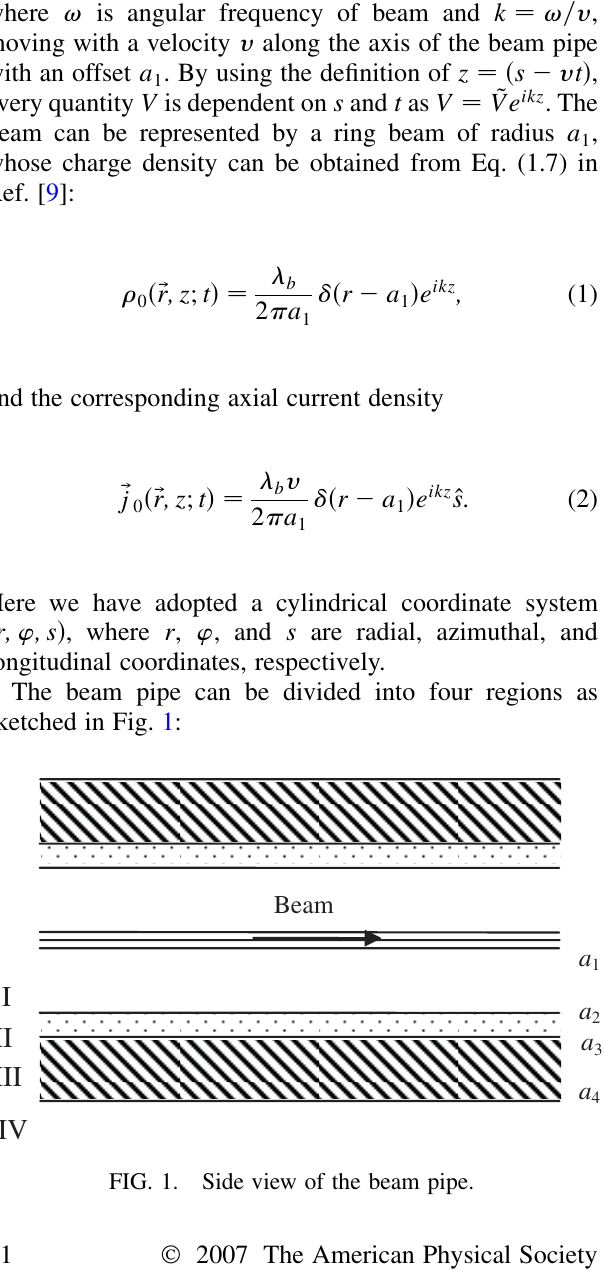
FIG. 1. Side view of the beam